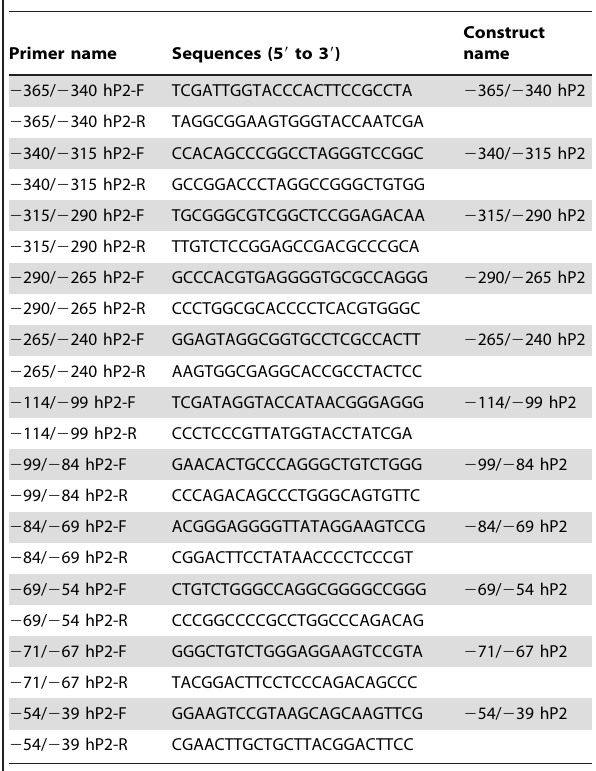
Table 2. Oligonucleotides used for generation of 25 bp deletion of 2 365/ 2 240 hP2, 15 bp deletion of 2 114/ 2 39 hP2 and 5 bp deletion of 2 114/ 2 39 hP2 promoter constructs.